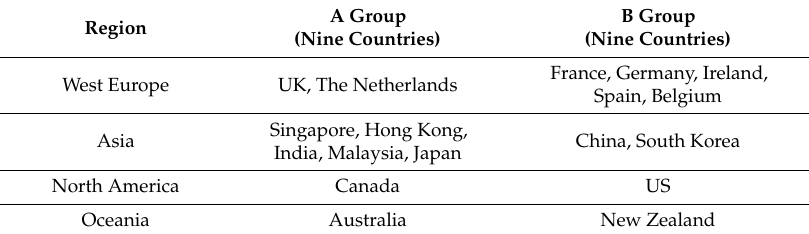
Table 7. The list of A group and B group countries.